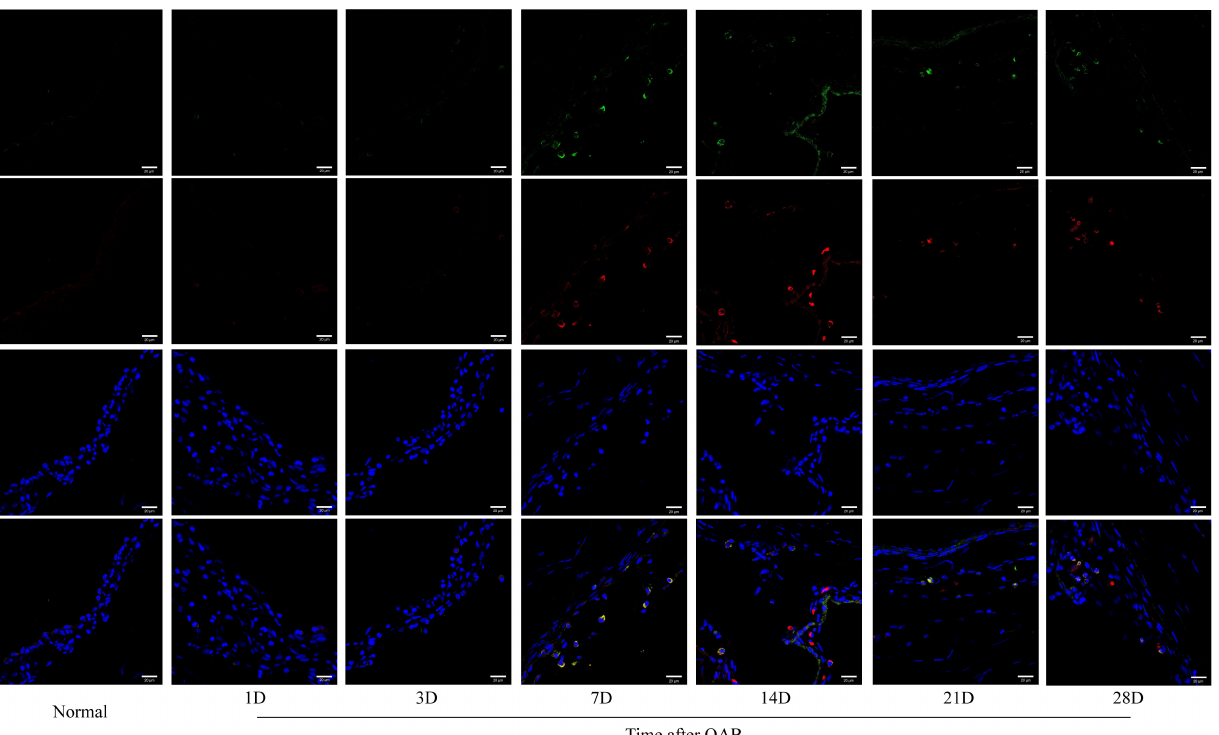
Figure 3. Immunofluorescence examination of normal control and OAB-subjected eyes ( n = 6 for each time point). Immunofluorescent staining of CD4 (green) and IL-17A (red) in the normal control and OAB-subjected eyes on the 1st, 3rd, 7th, 14th, 21st, and 28th day post modeling (40X). Cell nuclei were stained with DAPI (blue). CD4 and IL-17A double positive cells were found around the iris from days 7 to 28. Scale bar: 20 µ